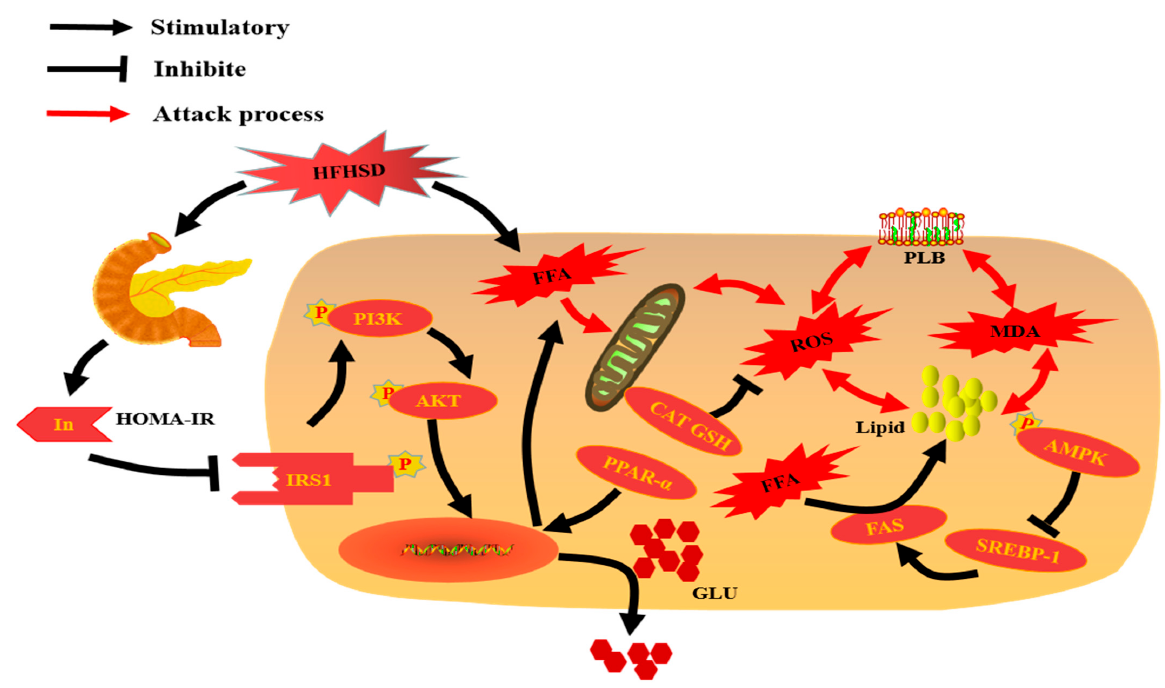
Figure 6. Schematic diagram of the main mechanism of glycolipid metabolism disorder pathways investigated in the present work. CAT: catalase; GSH: reduced glutathione; FFA: free fatty acid; ROS: reactive oxygen species; MDA: malonaldehyde; AMPK: amp-activated protein kinase; PPAR- α : peroxidase proliferative receptor- α ; HOMA-IR: homeostasis model assessment of insulin resistance; IRS1: insulin receptor substrate 1; PI3K, phosphoinositide 3 kinase; AKT: protein kinase B; SREBP-1: sterol regulatory element-binding protein1; HFHSD: high-fat and high-sugar diet; GLU: glucose; PLB: phos- pholipid bilayer; FAS: fatty acid synthase.